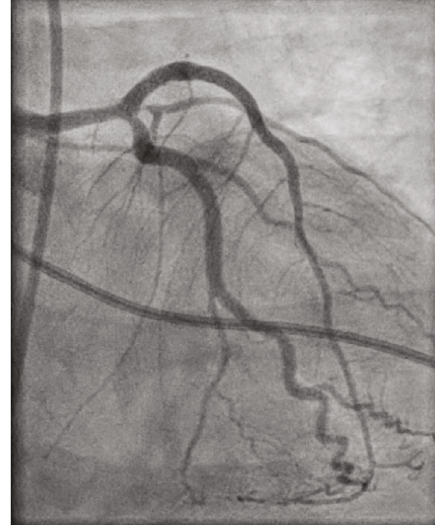
Figure 2: Restored perfusion established by percutaneous coronary angioplasty and stent